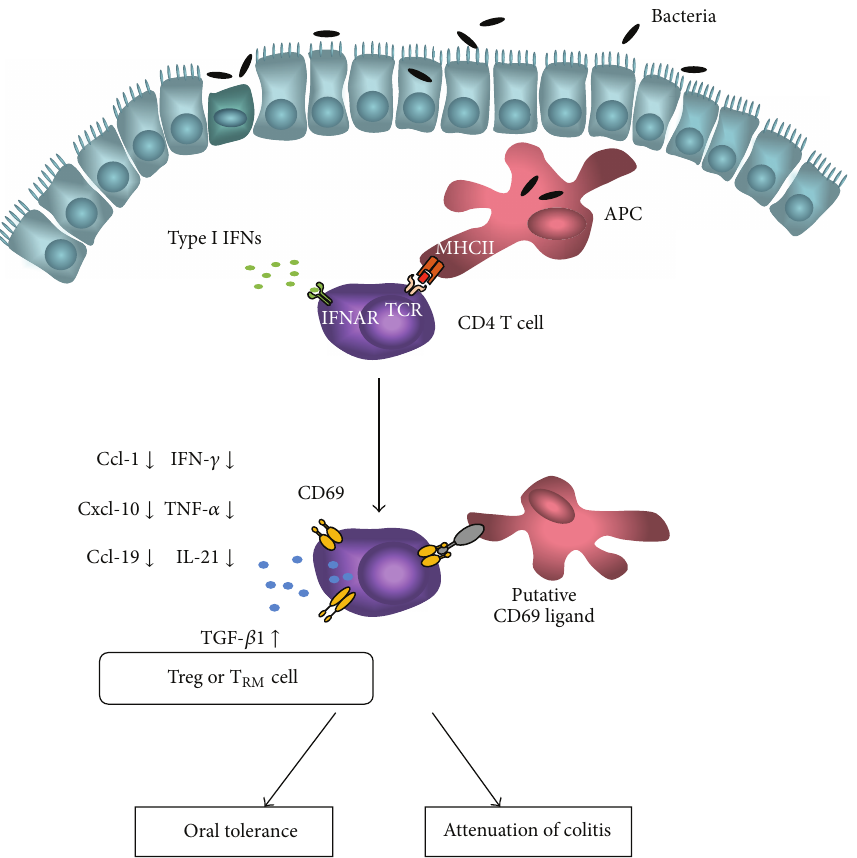
Figure 3: The role of CD69 in mucosal immunity. Activation of intestinal CD4 T cell by antigen recognition, type I interferons (IFN-I), or by presence of intestinal microflora leads to the upregulation of CD69 expression on the cell surface. After binding a ligand, CD69 activates the intracellular pathways that result in decreased production of proinflammatory cytokines (IFN- 𝛾 , TNF- 𝛼 , and IL-21) and chemokines (Ccl-1, Cxcl-10, and Ccl-19) and increased production of regulatory cytokine TGF- 𝛽 1. If the CD4 T cell establishes a stable expression of CD69, this cell can differentiate into CD69 + regulatory T cell (Treg) or tissue resident memory T cell (T RM ). Therefore, upregulation of CD69 leads to the decreased migration of activated CD4 T cells to the intestine and to the increased regulatory responses, which ensures the establishment of oral tolerance and the attenuation of colitis